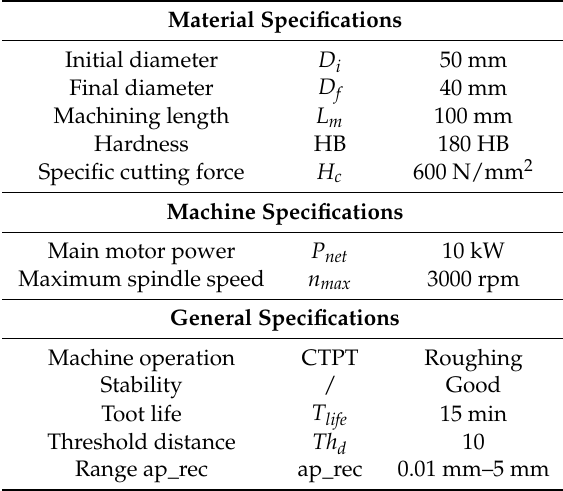
Table 9. Working specifications of the light roughing operation example.